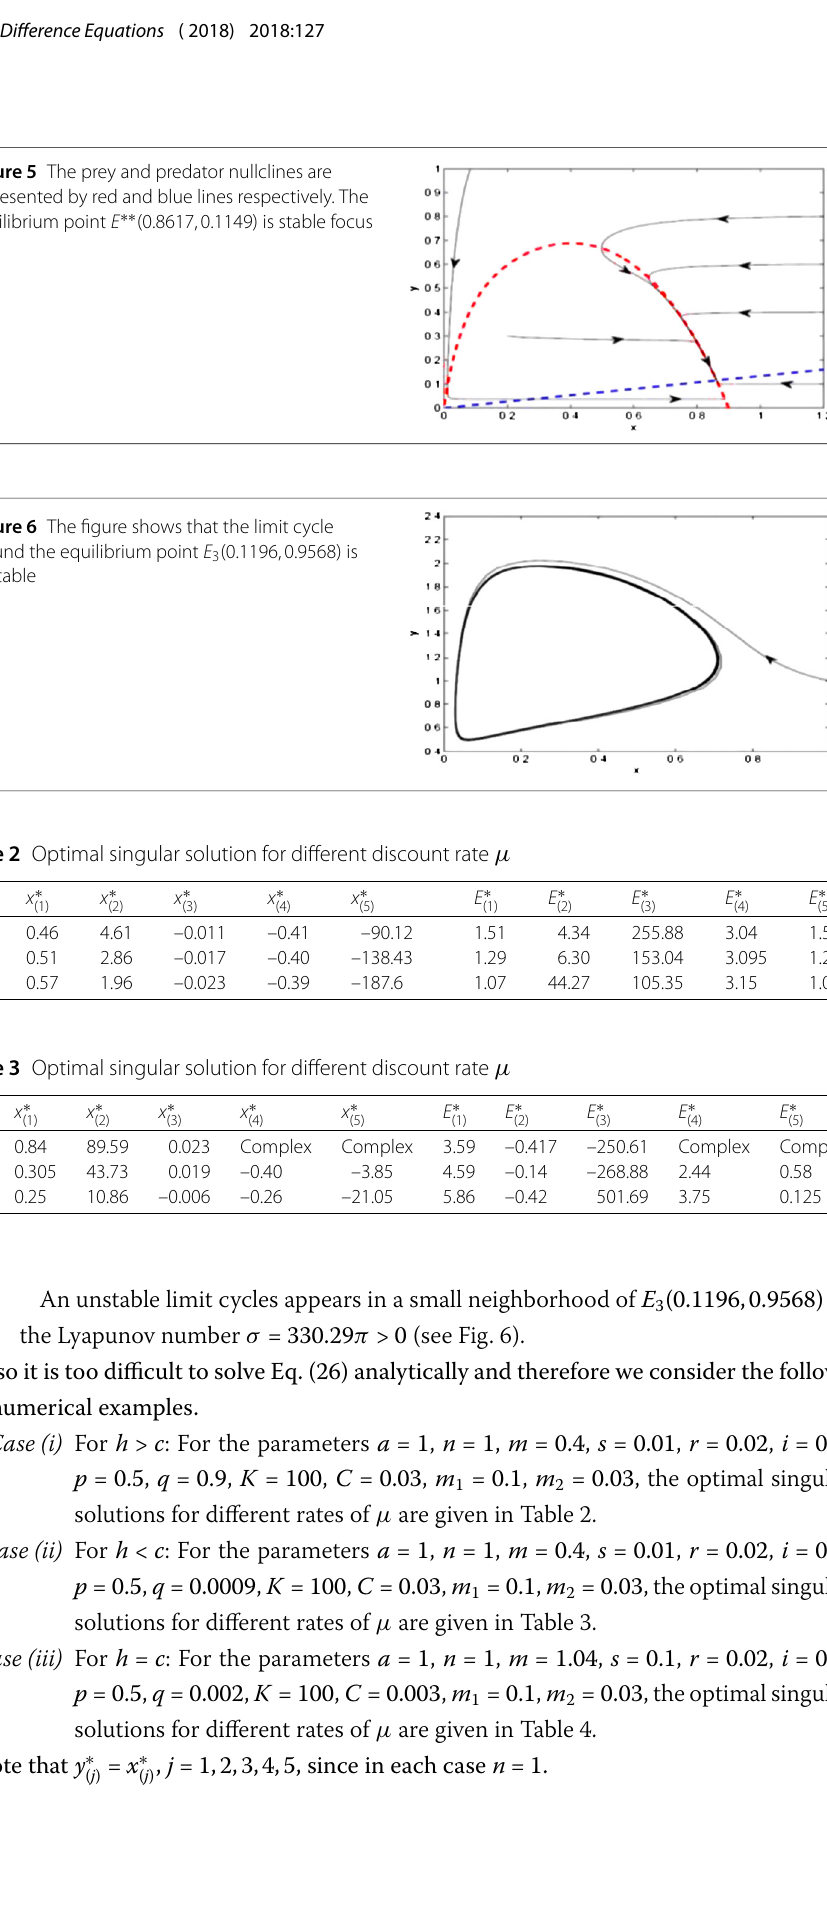
Figure 5 The prey and predator nullclines are represented by red and blue lines respectively. The equilibrium point E ∗∗ (0.8617,0.1149) is stable focus